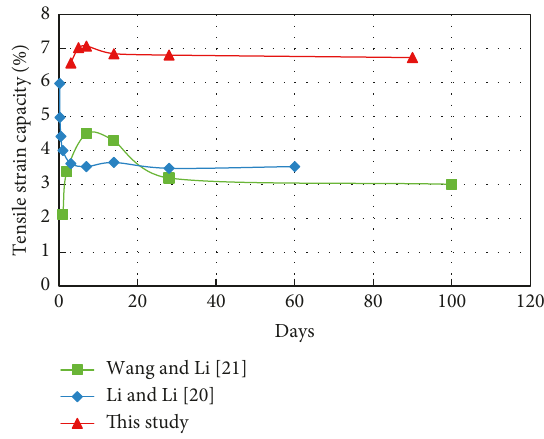
Figure 5: Tensile strain capacity of composites with time.